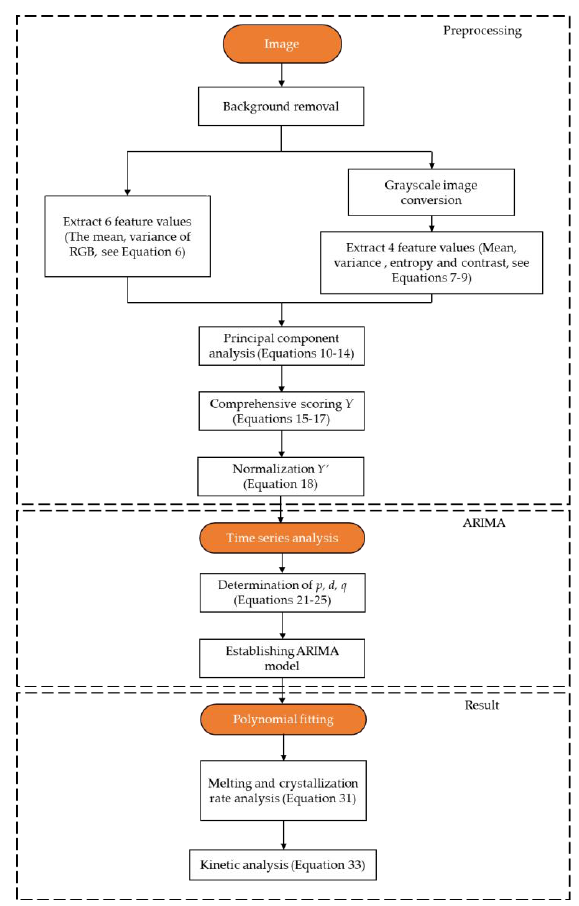
Figure 5. Schematic diagram of algorithm flow.